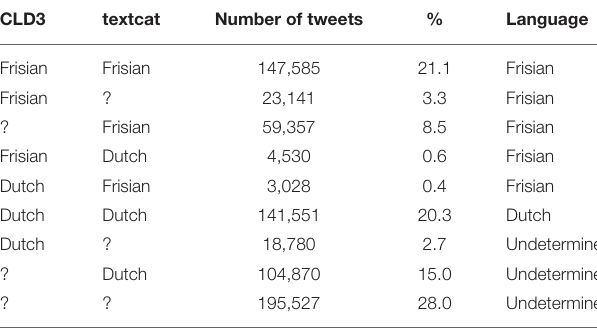
TABLE 2 | All variants of the target variables ( dy’t ), ( dêr’t ), ( wêr’t ), and ( wa’t ). Variable